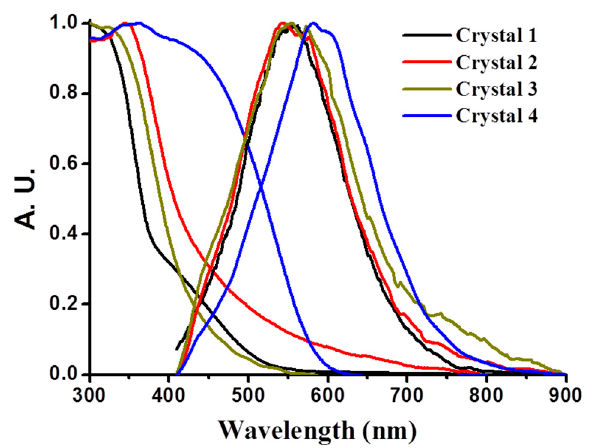
Figure 5. The UV–vis diffusive reflectance and emission spectra of 1 – 4 at λ ex = 325 nm.